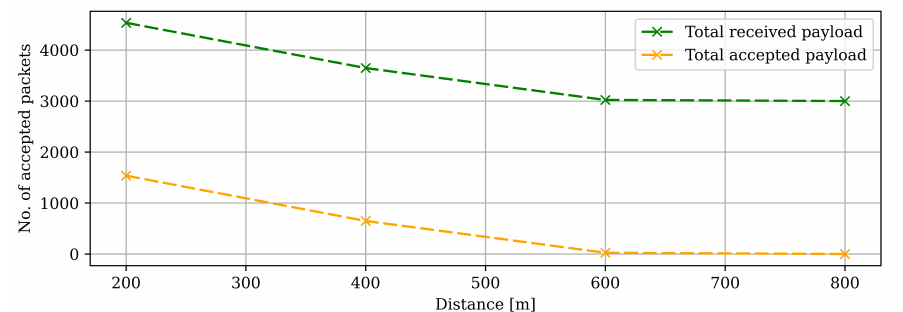
Figure 12. Preliminary testing area with no line of sight. Data on packages received by the NS, total vs. accepted.